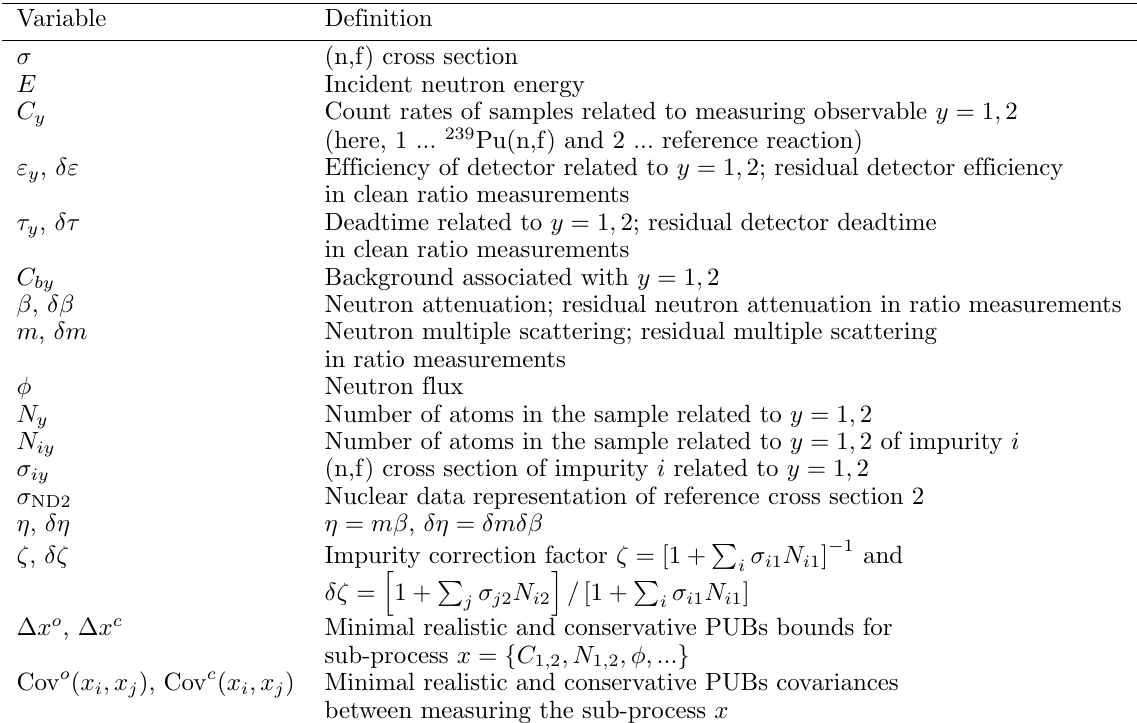
Table 3. Variables frequently appearing throughout this manuscript are listed in order of their